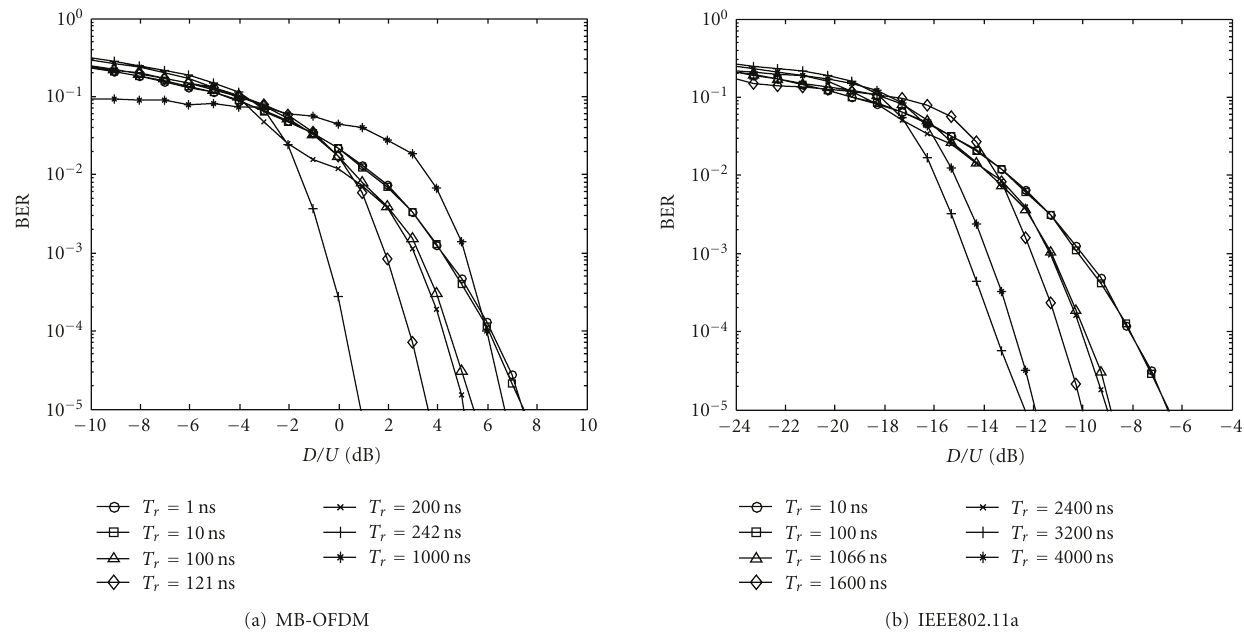
Figure 3: BER performance of OFDM interfered with by p-UWB ( E b /N 0 = 20